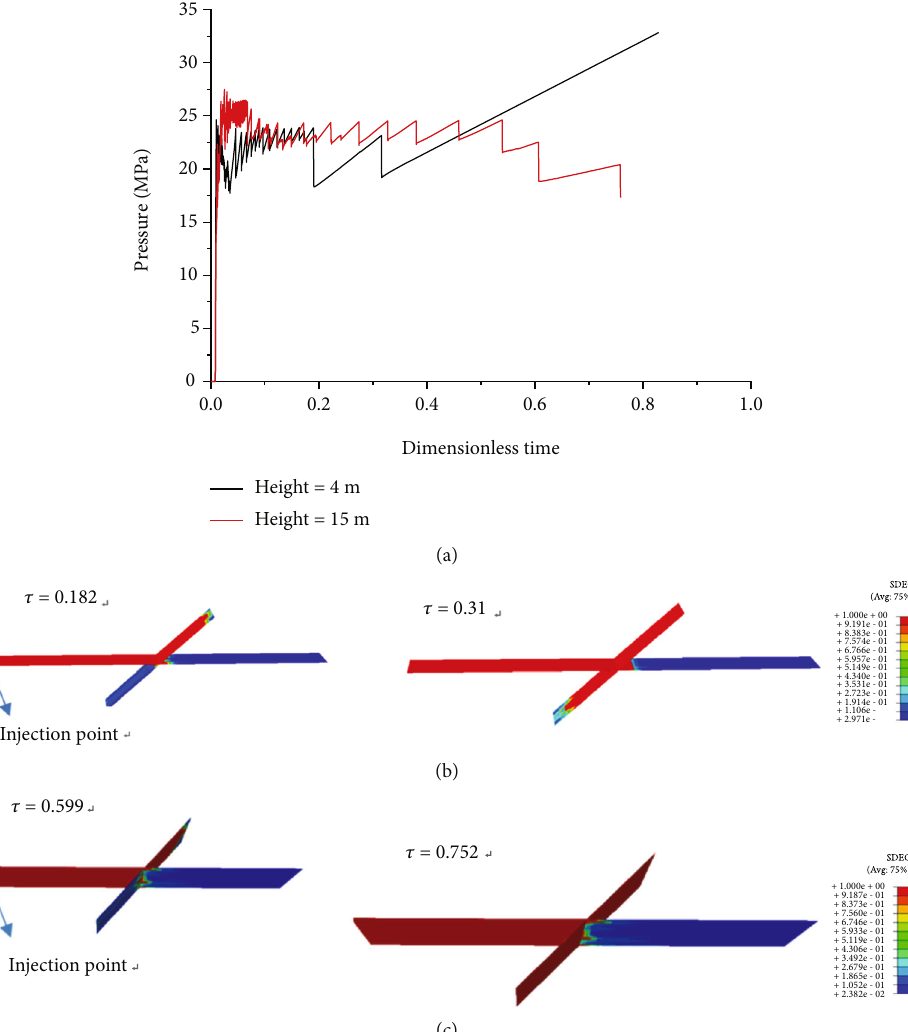
Figure 11: The numerical result comparison between 4m and 15m formation thickness with a 45-degree approaching angle: (a) the fl uid pressure history at the injection point; (b) damage factor (SDEG) contours with a 4m formation thickness (deformation scale factor is 100); and (c) damage factor (SDEG) contours with a 15 m formation